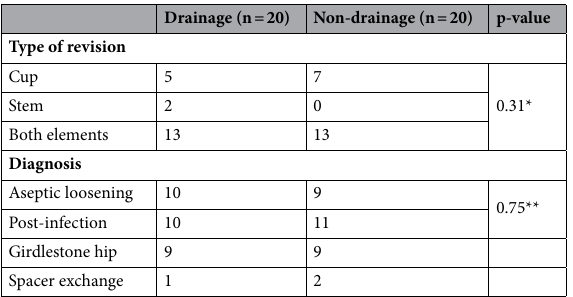
Table 1. Type of procedure and preoperative diagnosis. *Chi 2 Test (3 × 2). **Chi 2 Test (2 × 2).